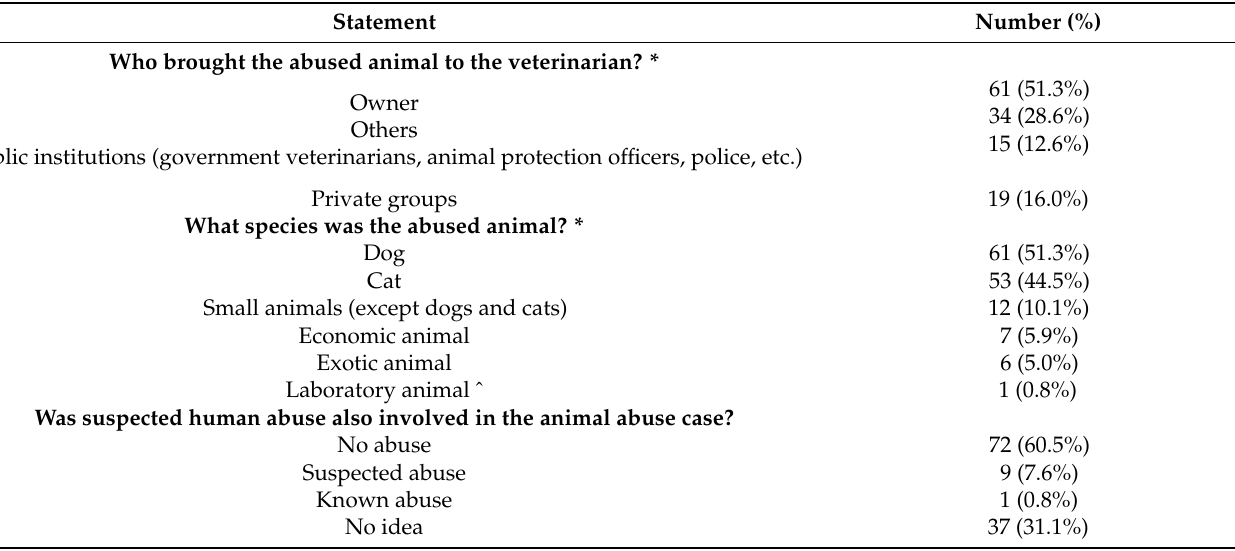
Table 10. Who brought physically abused animals to the veterinarian, what species of abused animal was involved, and whether interpersonal violence was also involved in the animal abuse case. The results were calculated only from the answers of 119 veterinarians who claimed they had the knowledge to identify physical abuse, or who had encountered abuse cases.